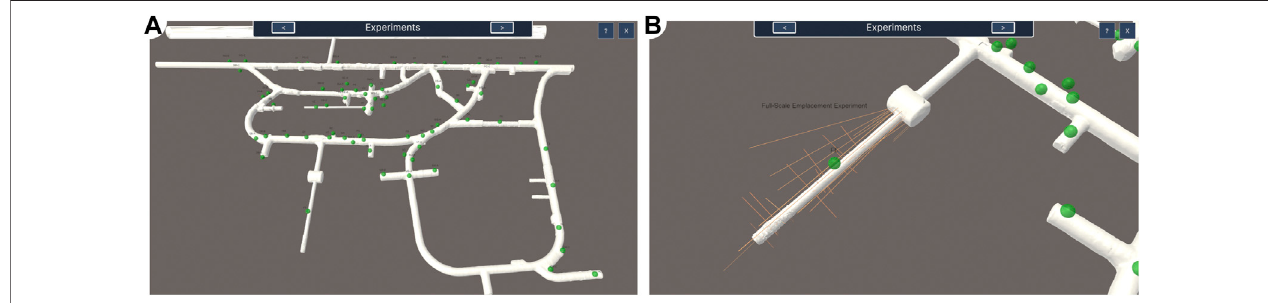
FIGURE4| ExperimentsattheMontTerriURL (A) anoverviewofthemostimportantexperimentsand (B) displayoftheassociatedboreholesaftertheselectionof one